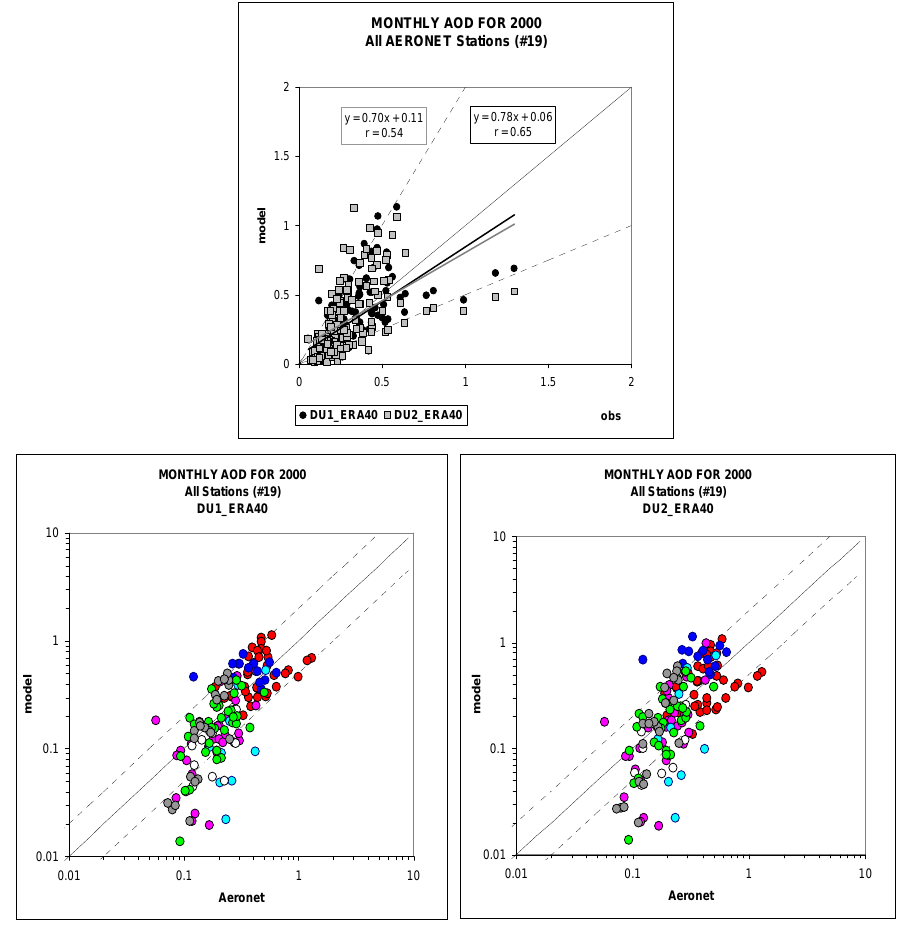
Fig. 12. Scatter plots (upper: linear, lower: logarithmic) of the modelled versus measured monthly AOD 550nm from the AERONET stations for the DU1 ERA40 and the DU2 ERA40 simulations. The stations are shown in Fig. 3d and the colour of the dots corresponds to the location of each station: Africa = red, Indian Ocean = white, Europe = grey, Middle East = green, S-America = purple, Arabian Peninsula = blue, Asia = cyan. The dotted lines denote the 1 : 2 to 2 : 1 range. A seasonal analysis of the above comparison is included in Fig. S4 of the